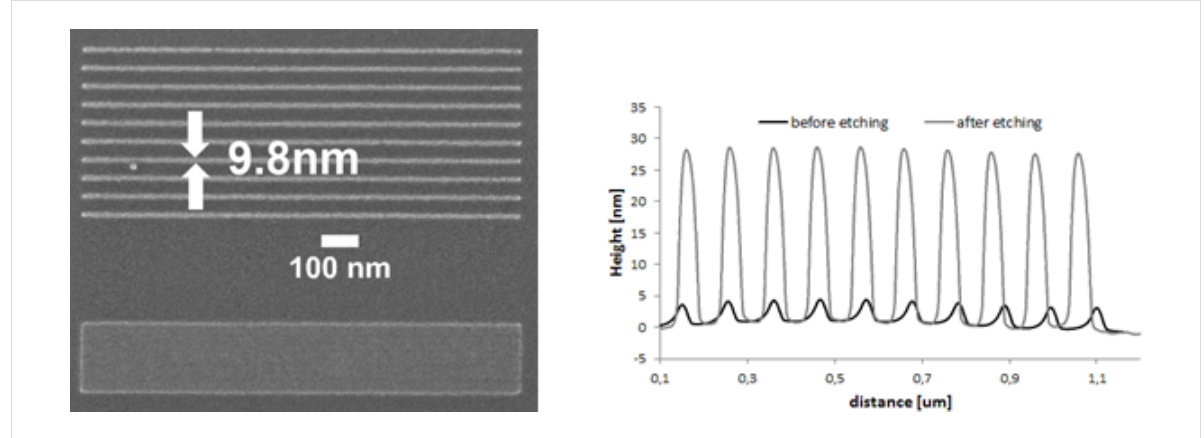
Figure 13: Left: SEM micrograph of an EBID mask consisting of 17 nm lines at 50 nm spacing, transferred into the silicon substrate using fluorine etch. Right: AFM profile showing a height ratio before and after etching of 8 [105].